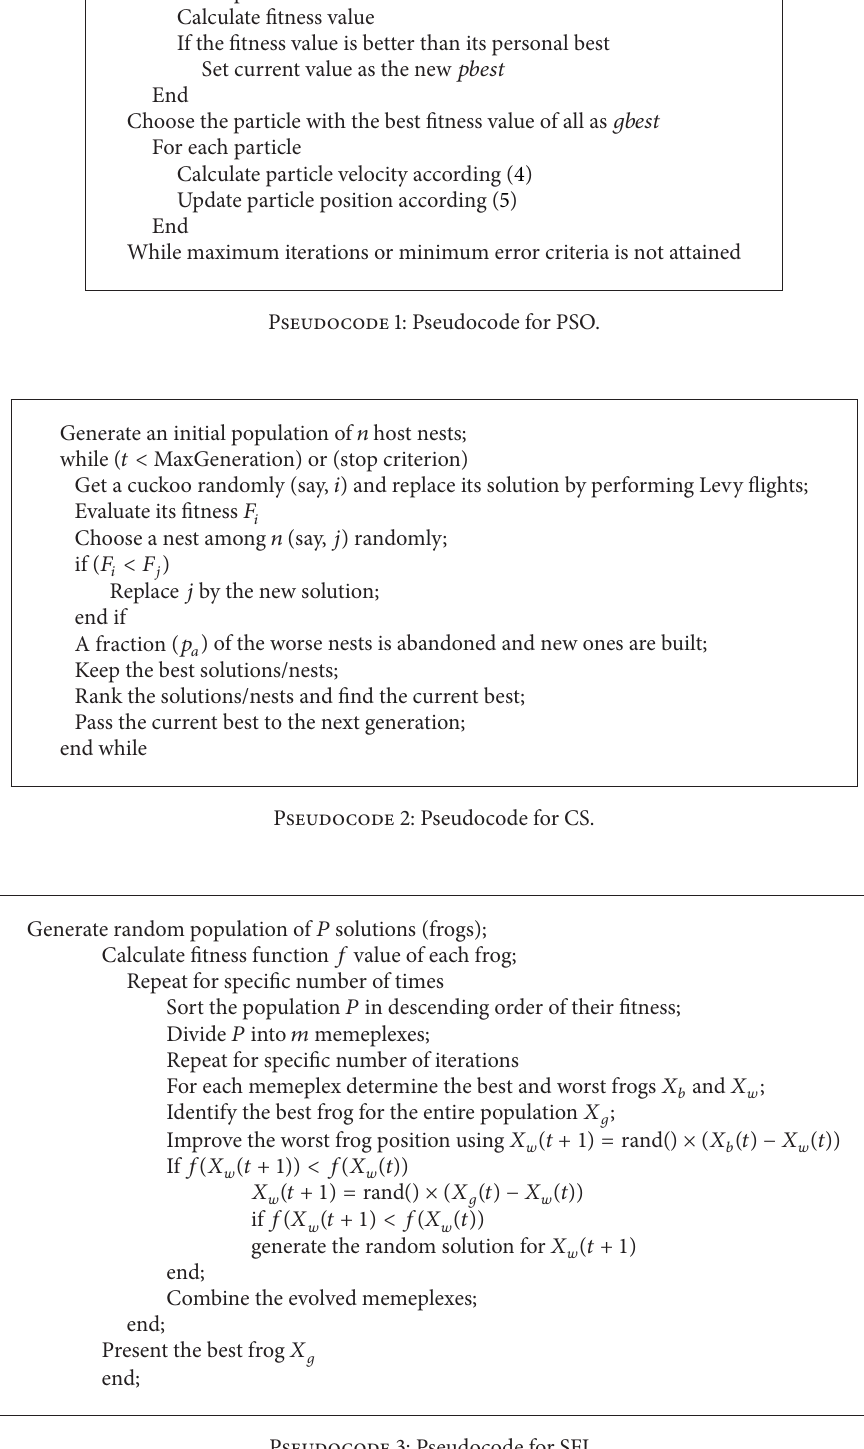
Pseudocode 3: Pseudocode for